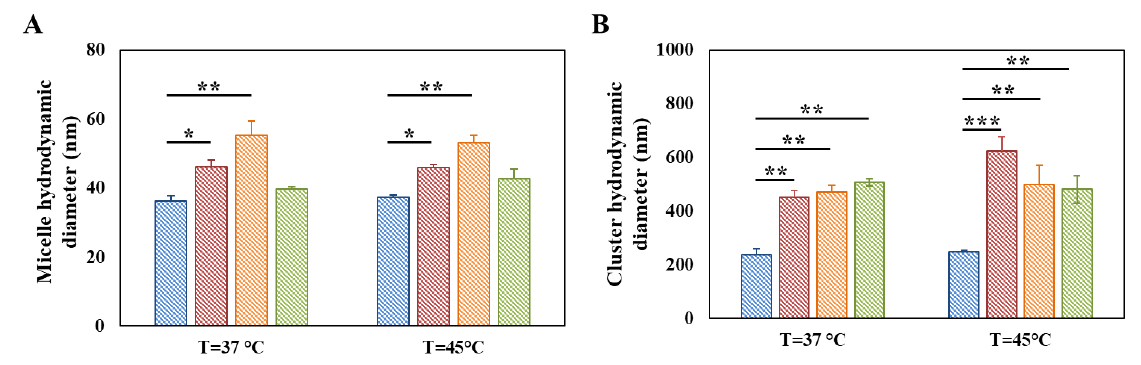
Figure 6. Average micelle ( A ) and cluster ( B ) hydrodynamic diameters measured for D-DHP407 (blue), S-DHP407 (red), A-DHP407 (orange) and NB-DHP407 (green) samples at 0.5% w/v concen- tration and different temperatures (i.e., 37 °C and 45 °C). Statistical significance: 0.0001 < p < 0.001 = ***, 0.001 < p < 0.01 = **, 0.01 < p < 0.5 = *.